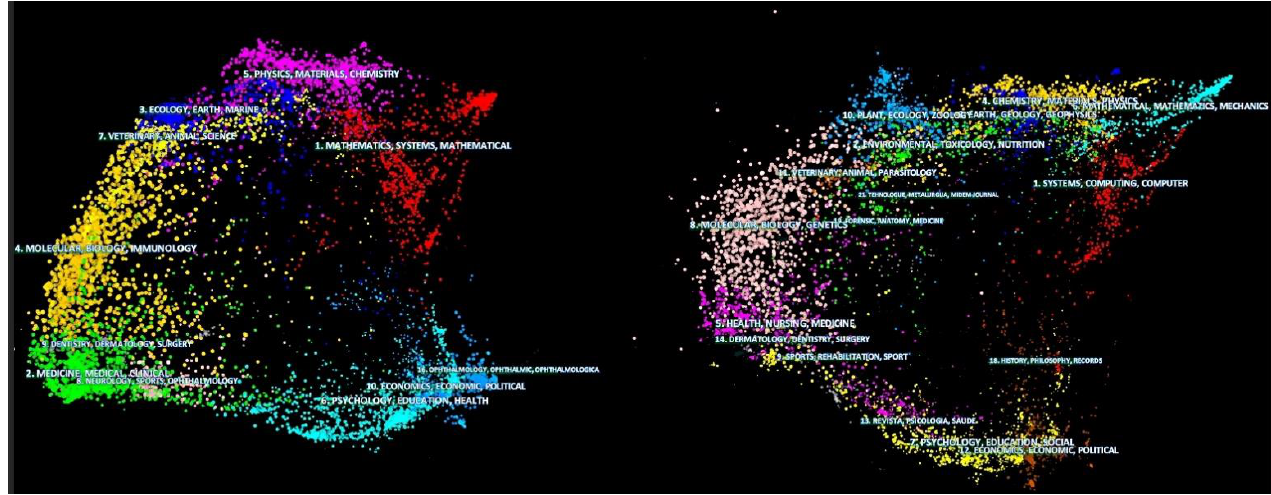
Figure 12. The Citespace interface as it first appeared, with citing and cited journal base maps shown concurrently. On the left is a base map with 10,330 citing journals. On the right is a base map with 10,253 referenced journals. Blondel’s clustering method identified the groupings in various colors [74].